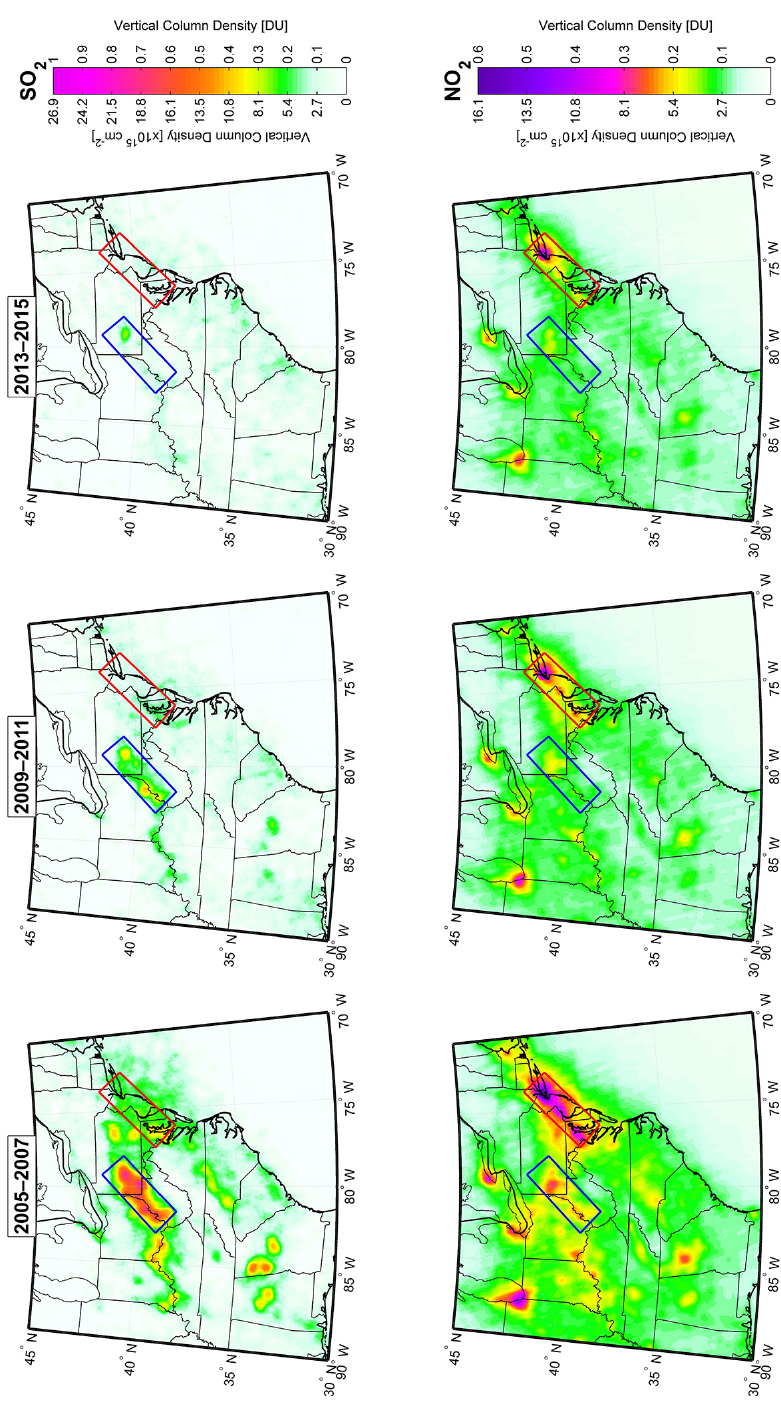
Figure 2. 3-year average OMI SO 2 (top) and tropospheric NO 2 (bottom) regional maps over the eastern US for 3 periods: 2005–2007 (left), 2009–2011 (middle) and 2013–2015 (right). The blue box outlines the Ohio River valley and SW Pennsylvania (ORV) region with the largest SO 2 emissions from coal-fired power plants. The red box outlines the megalopolis from Washington, DC to New York along the I-95 interstate highway (I-95 corridor) with largest NO 2 from mobile